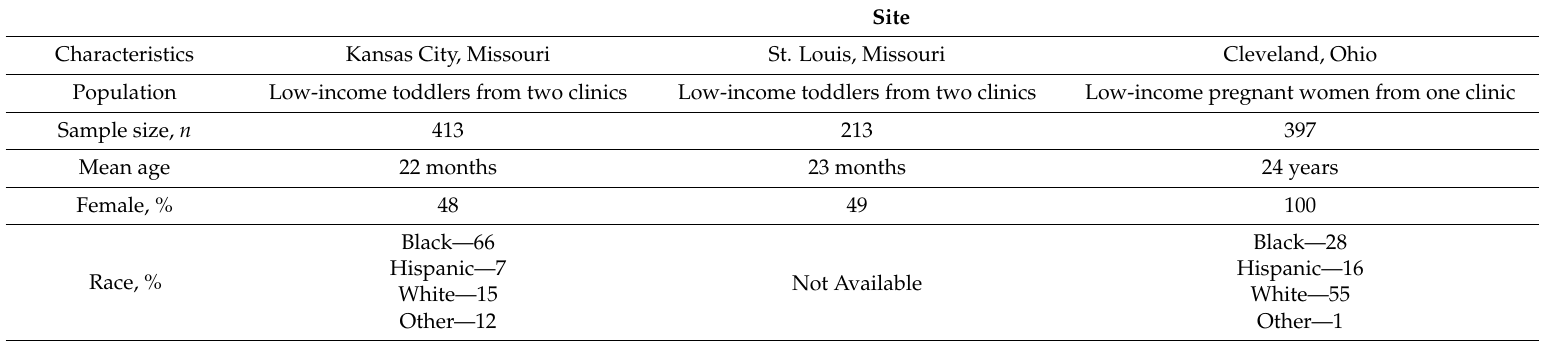
Table 1. Sociodemographic characteristics of participants * by site.